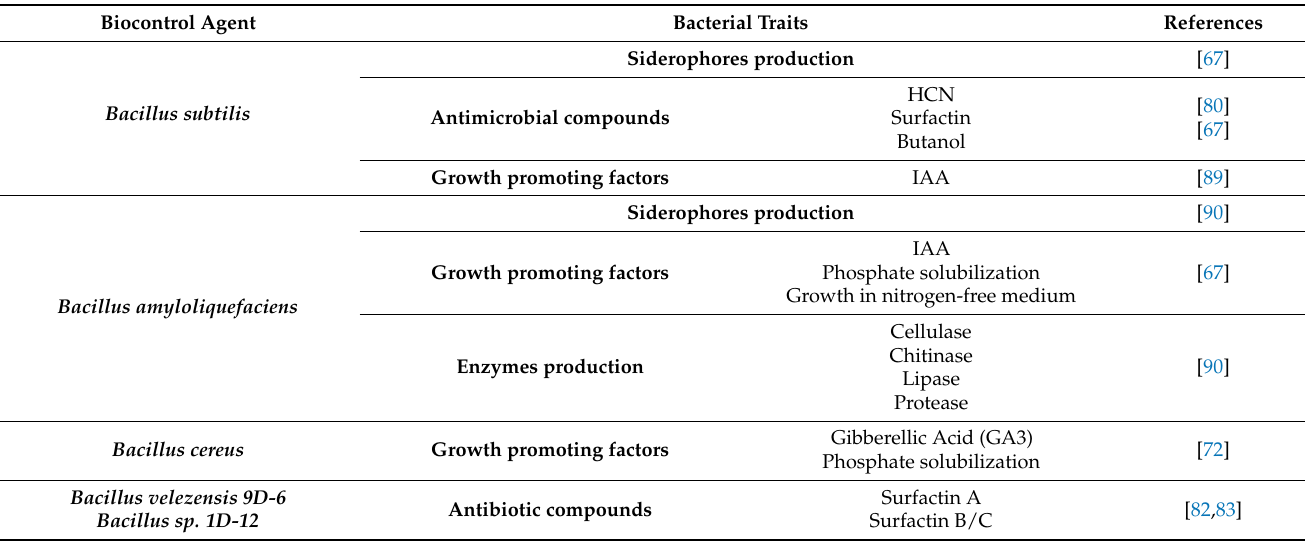
Table 2. Overview of the modes of action of Bacillus strains to foster plant growth and to control C. michiganensis